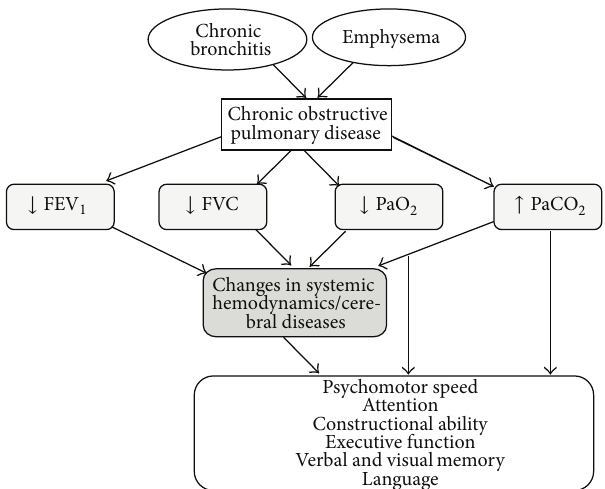
Figure 1: Potential COPD mechanism by which cognitive functions are